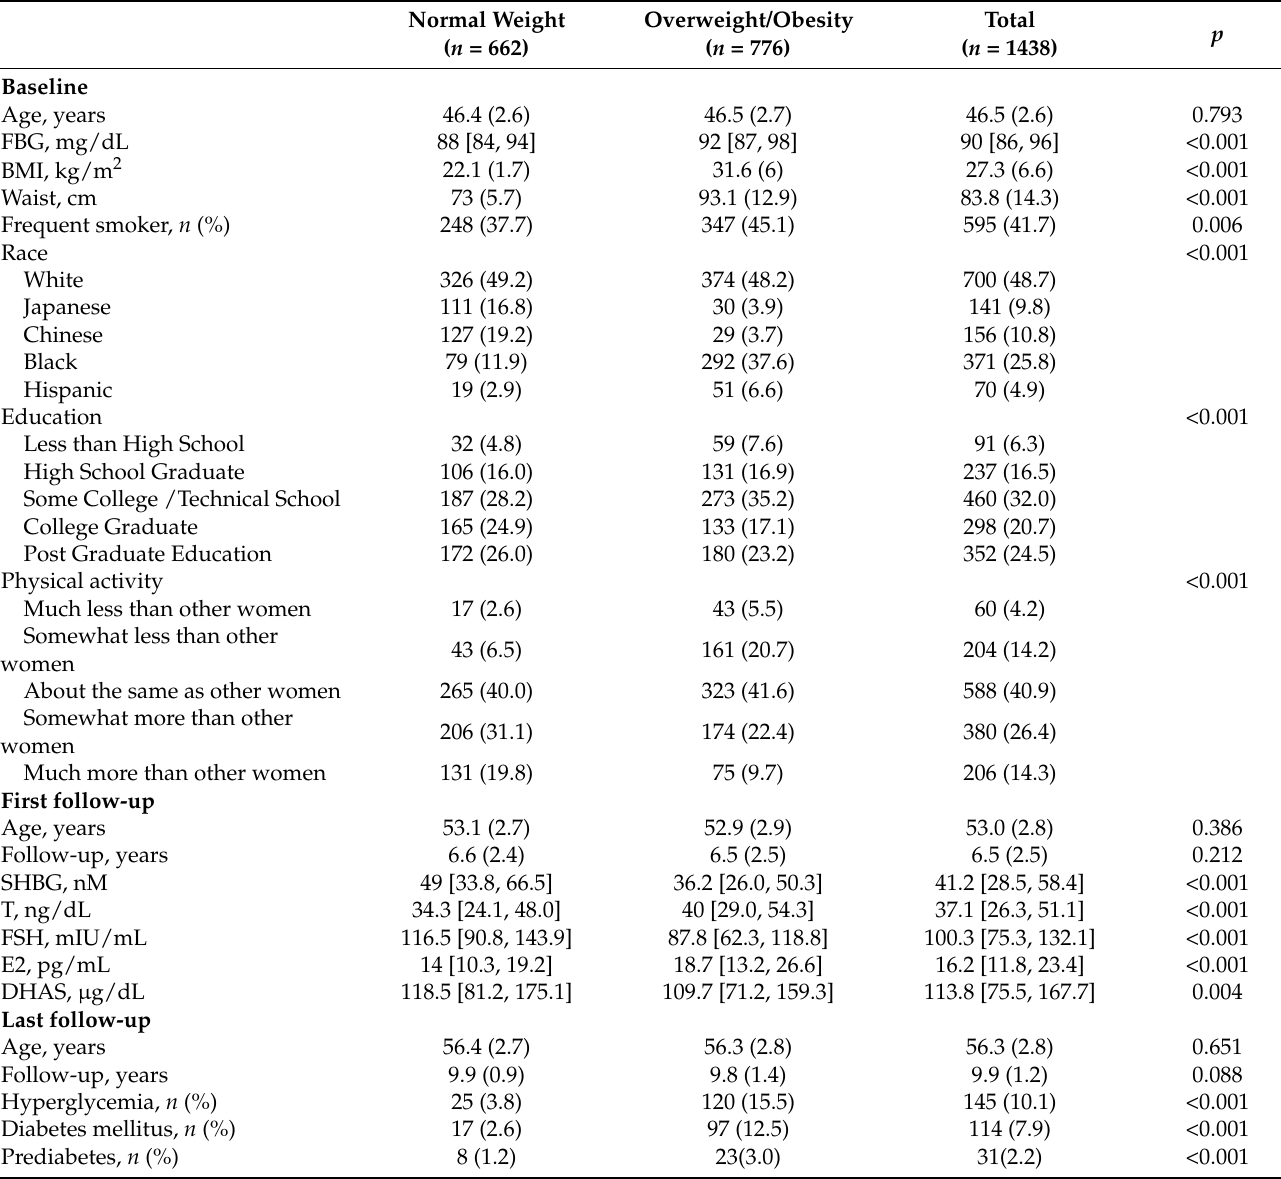
Table 1. Characteristics of participants at baseline and